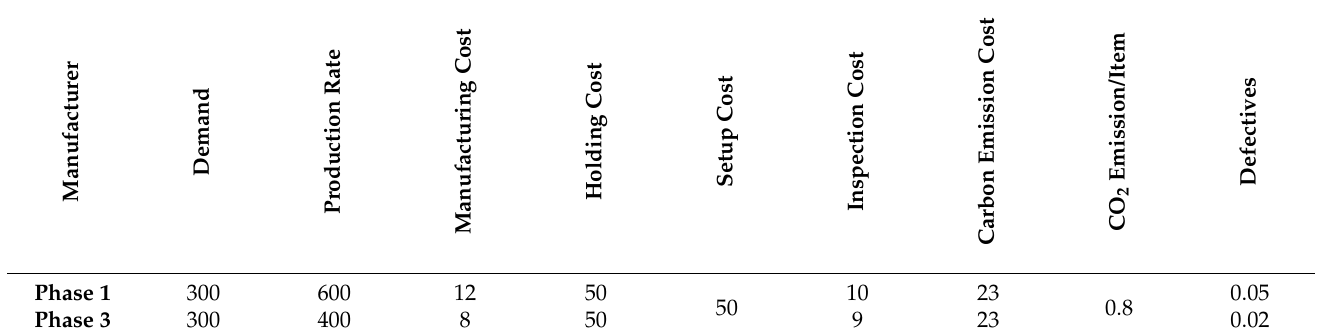
Table 2. Manufacturing data for phase 1 and phase 3 (spare-part-manufacturing industry).